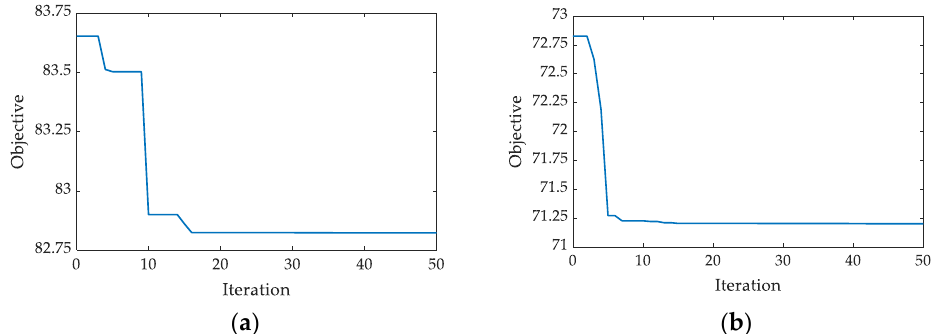
Figure 6. The process of PSO optimization iteration: ( a ) optimization scheme A; ( b ) optimization scheme B.